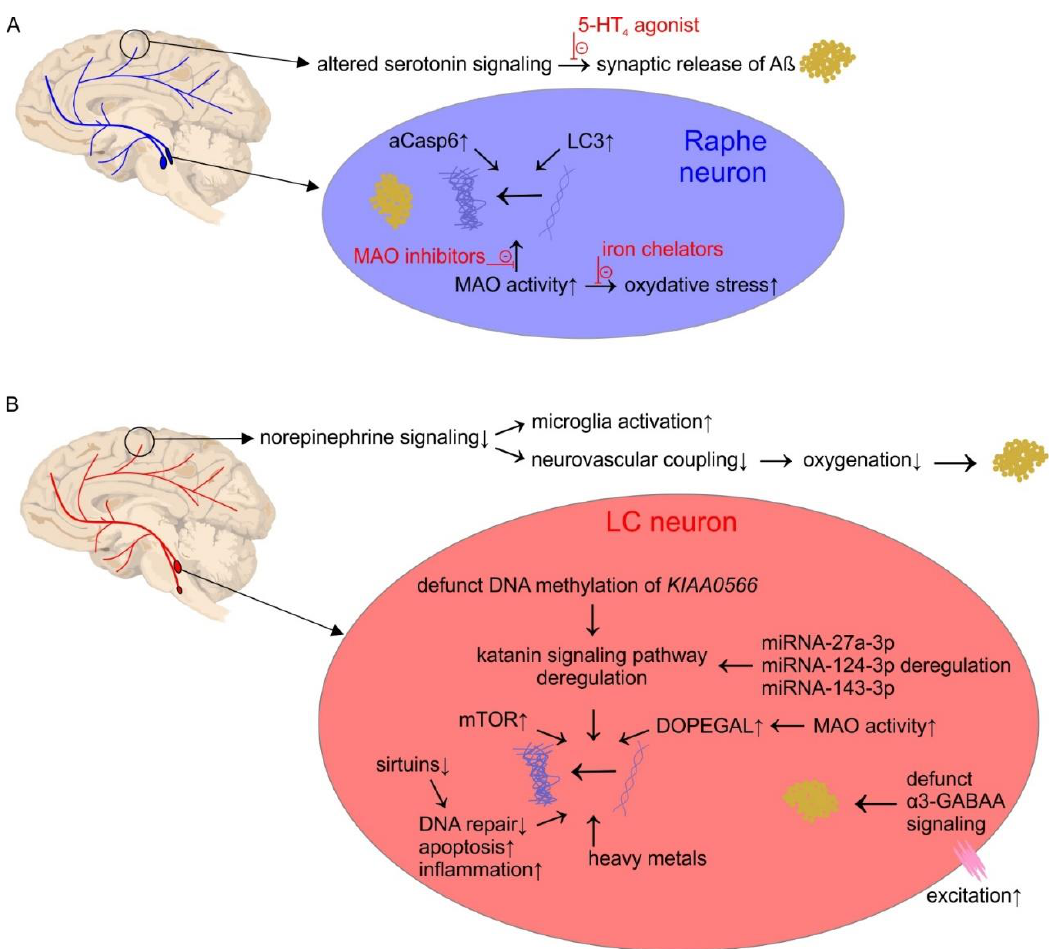
Figure 1. ( A ) Cortical and brain stem pathology of serotonin neurons in Alzheimer’s disease (AD). Agents written in red indicated therapeutic targets. ( B ) Cortical and brainstem pathology of norepinephrine neurons in AD. Abbreviations: DOPEGAL: 3,4-dihydroxyphenylglycolaldehyde, MAO: monoamine oxydase, LC: locus coerules, mTOR: mechanistic target of